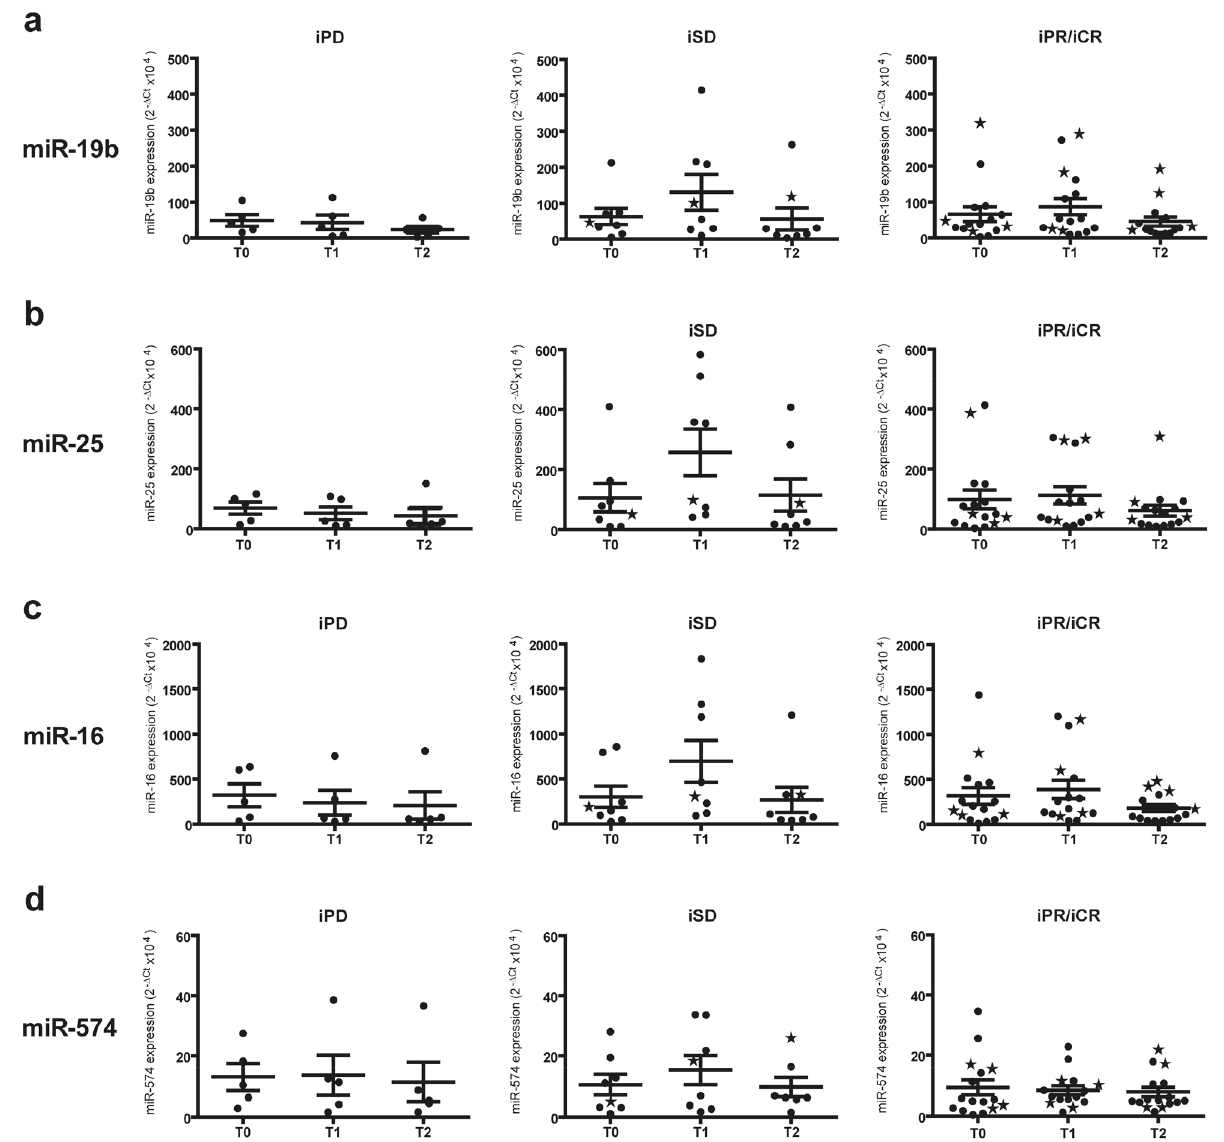
Figure 6. Plasma miRNA expression in melanoma patients treated with CPIs. Quantitative RT-PCR analysis of ( a ) miR-19b, ( b ) miR-25, ( c ) miR-16, and ( d ) miR-574 expression in plasma samples obtained from melanoma patients, before (T0) and after 1 month (T1) and 3 months (T2) of treatment. Best overall response according to iRECIST criteria: iPD, progressive disease (n. 5 patients); iSD, stable disease (n. 8 patients); iPR/iCR, partial response/immune complete response (n. 16 patients). The data were normalized to the level of cel-miR-39 in × each sample and expressed as 2 −ΔCt 10 4 values. Dots represent each patient values; largest bars, arithmetic mean; small bars, SEM. Stars indicate patients who had developed leukoderma at the data cut